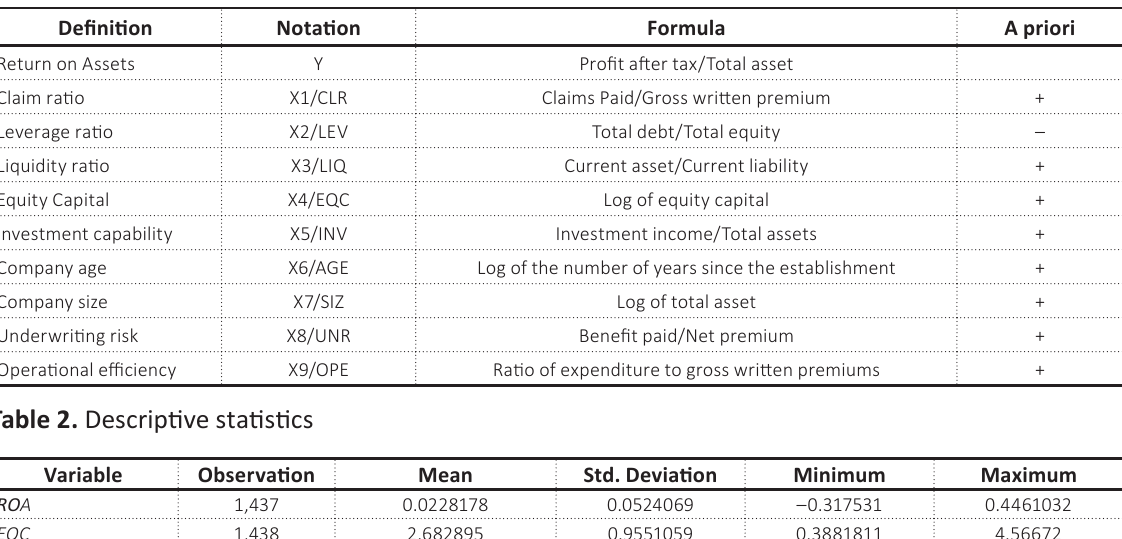
Table 1. Variable definition and